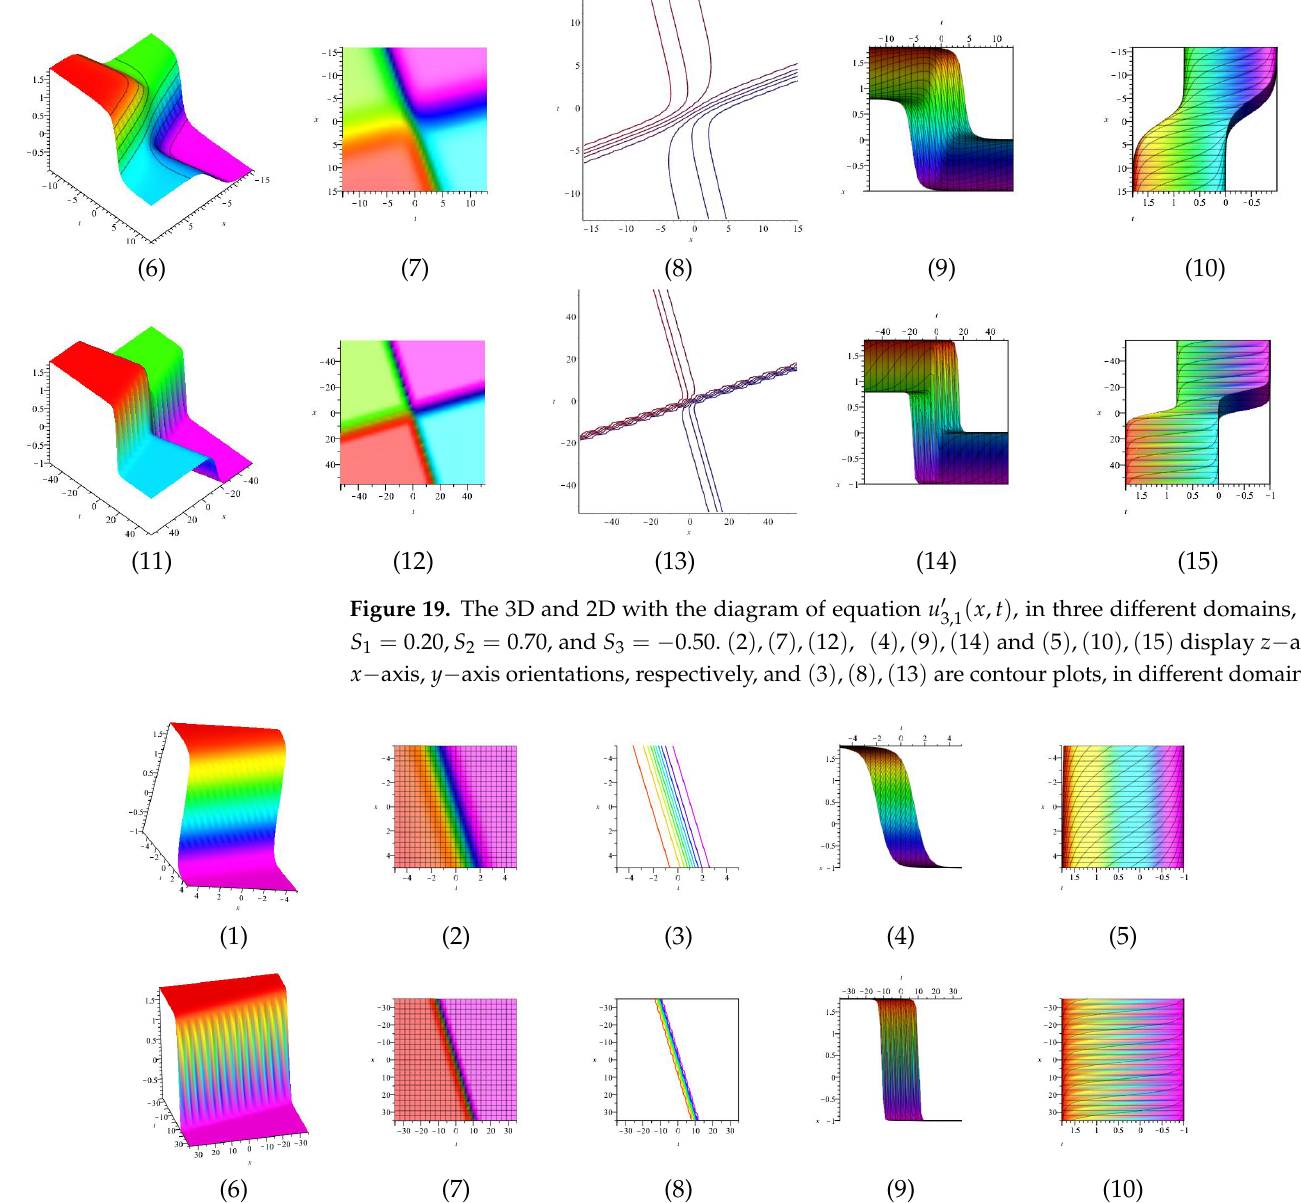
( x , t ) , in three different domains, for 3,2